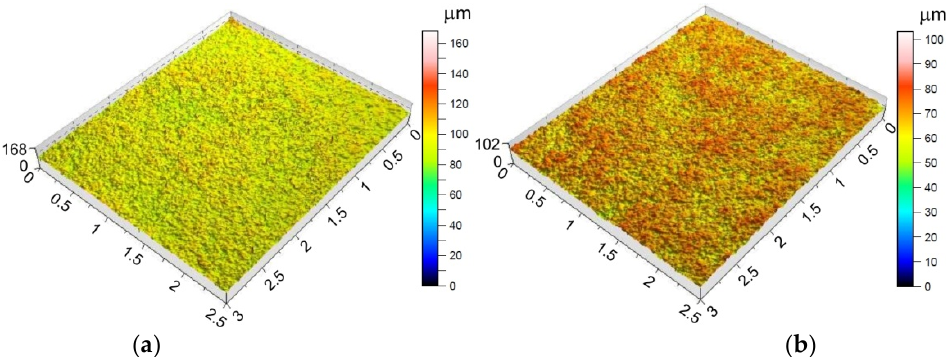
Figure 12. Topography of the outside surface of the drawpieces formed at a p = 0.5 mm, f = 500 mm/min, n = 600 rpm and toolpath strategy: ( a ) conventional and ( b ) climb.